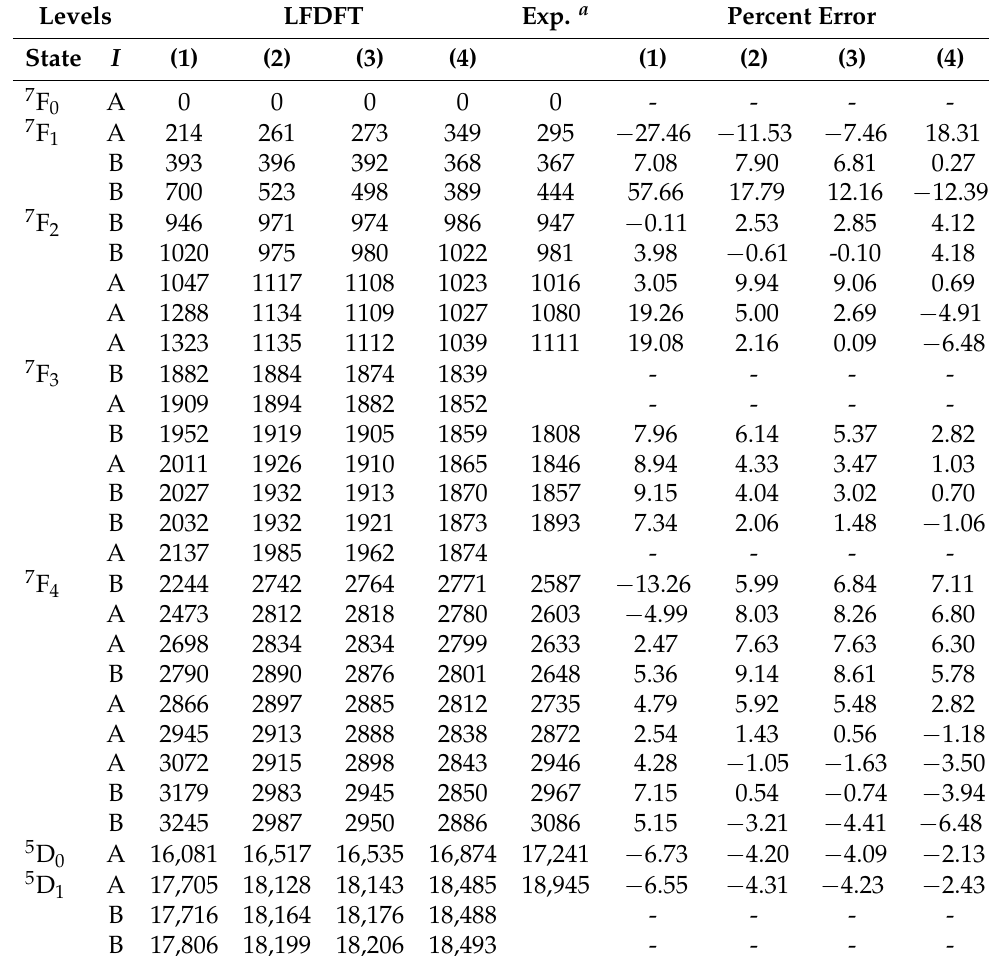
Table 1. Selective energy values of the multiplet states of Eu 2 + configuration 4 f 6 (in cm − 1 ) in the system [Eu(NO 3 ) 3 (phenanthroline) 2 ] obtained from LFDFT using the PBE (1) [37], B3LYP (2) [38], PBE0 (3) [39,40] and KMLYP (4) [41] functional, together with the calculated Percent Error (in%) with respect to the experimental data